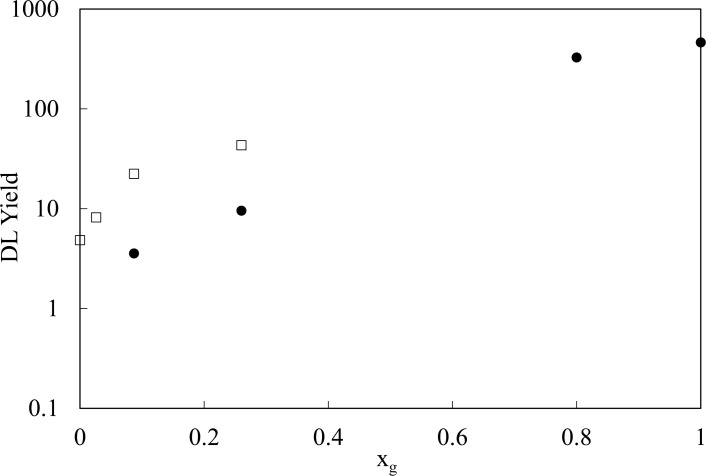
Delayed luminescence yield vs glycerol mole fraction.DL yield, according Eq 7, as a function of glycerol mole fraction xg: (●)022f5cg DLfast, (□) DLslow. Standard errors are within the markers size.